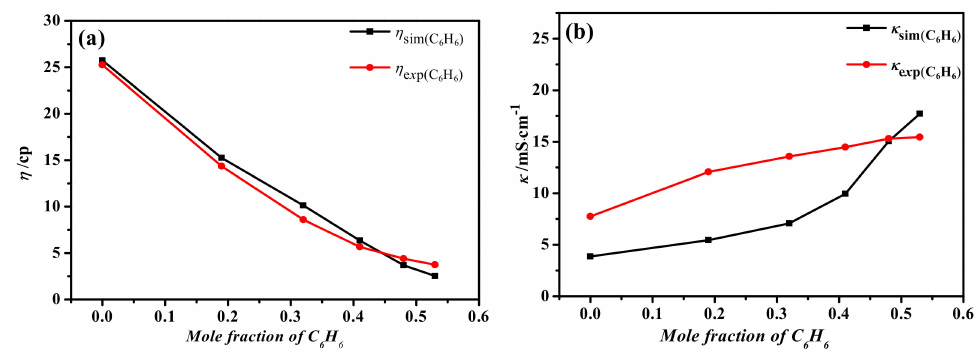
Figure 5. Effects of the C 6 H 6 mole fractions on viscosity ( a ) and conductivity ( b ) in [Et 3 NH]Cl/AlCl 3 system.